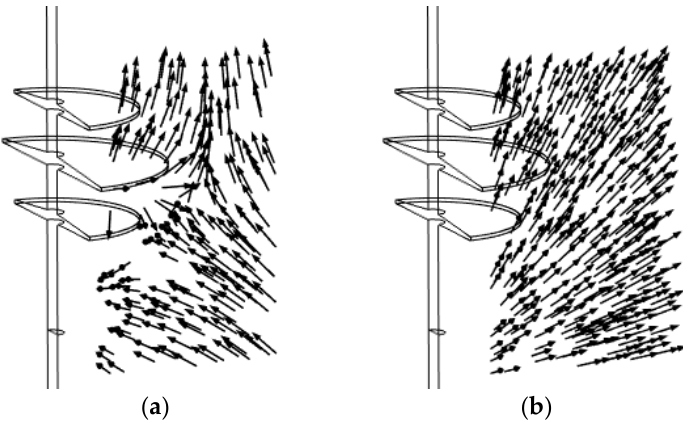
Figure 6. The direction map of ( a ) air drag force and ( b ) electric force on particles at 0.19 s after release.